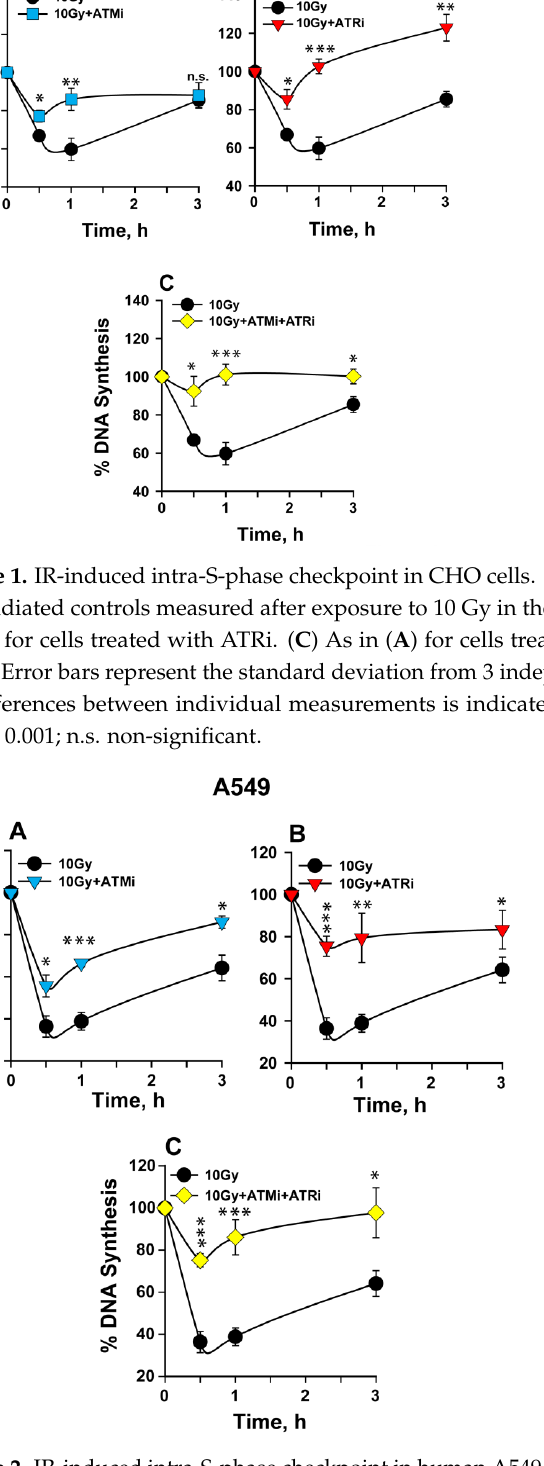
Figure 2. IR-induced intra-S-phase checkpoint in human A549 cells. ( A ) Percentage of DNA synthe- sis over unirradiated controls measured after exposure to 10 Gy of IR in the presence or absence of ATMi. ( B ) As in ( A ) for cells treated with ATRi. ( C ) As in ( A ) for cells treated with a combination of ATMi and ATRi. Error bars represent standard deviations from 3 to 4 independent experiments. The significance of differences between individual measurements is indicated by * symbol: * p < 0.05, ** p < 0.01, *** p <